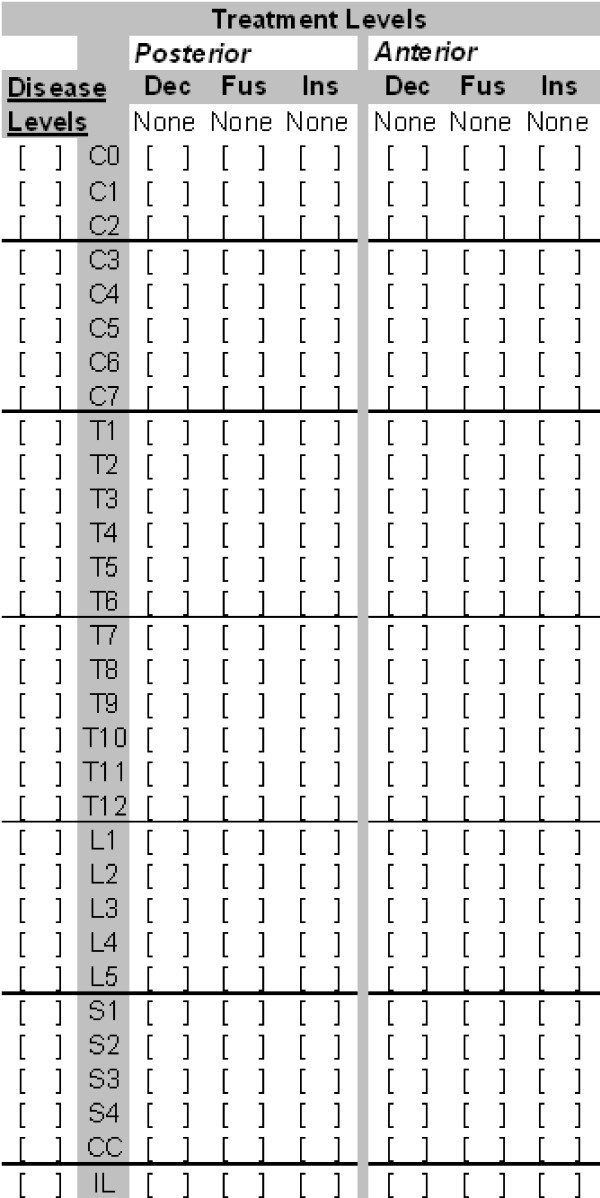
Graphical Grid for Coding Surgical Procedures. Graphical grid used to code components of the surgical procedure. Each vertebral level is designated by a row. The columns identify the possible surgical procedures performed at each level: posterior decompression, posterior fusion, posterior instrumentation, anterior decompression, anterior fusion and anterior instrumentation.